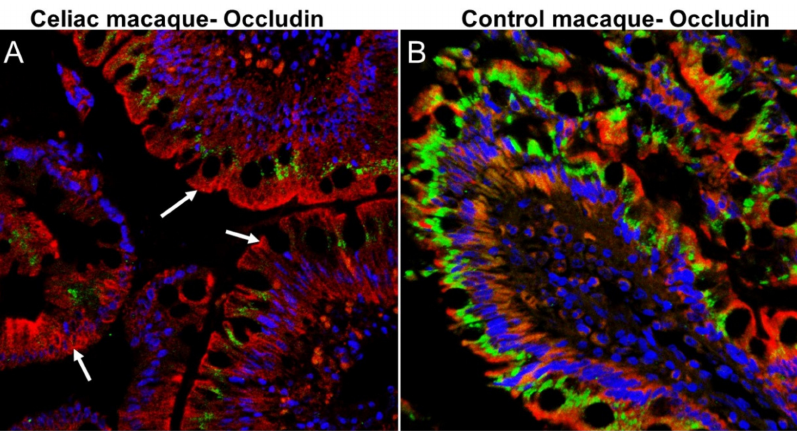
Figure 1. Occludin (OCLN) protein expression is significantly decreased in duodenal epithelium of celiac macaques. All panels involve triple labels with OCLN ( green ), cytokeratin ( red ) and Topro3 for nuclear staining ( blue ). Colocalization appears yellow. Note the marked loss of occludin protein (white arrow) staining in the duodenal epithelium (DE) of the celiac macaque ( A ). In contrast, occludin protein ( B ) staining is intense in the DE of the control macaque. Magnification for both panels is 40 × . Occludin (Cat#LS-B2437) antibody that cross reacts with the rhesus macaque was purchased from Lifespan Biosciences, Seattle, WA,